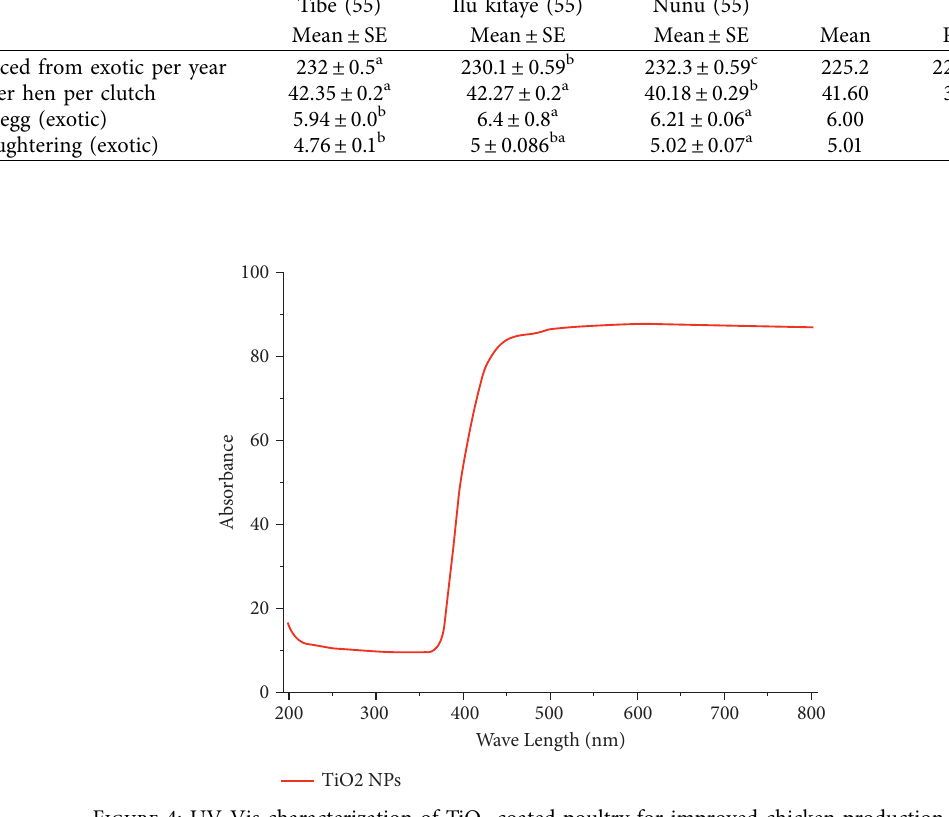
Figure 4: UV-Vis characterization of TiO 2 coated poultry for improved chicken